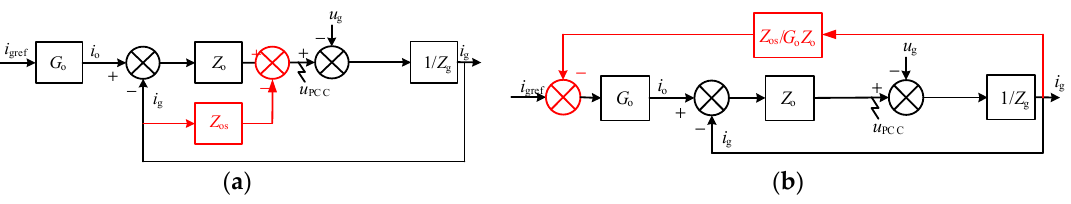
Figure 3. Block diagram of reshaping output impedance: ( a ) impedance model; ( b ) deformed impedance model.